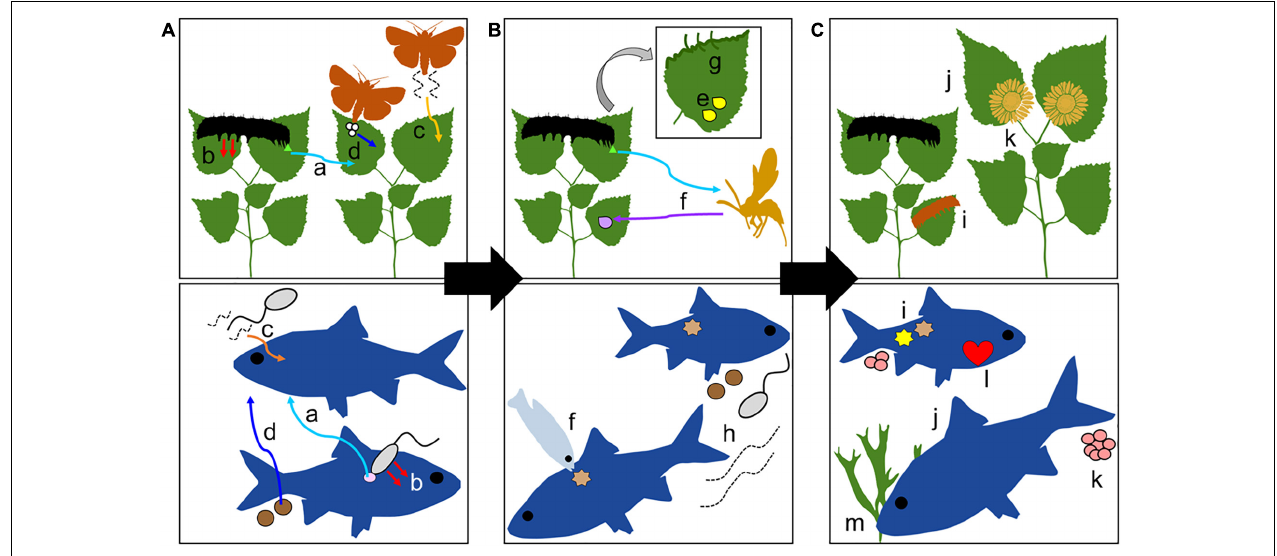
FIGURE 1 | Select broad similarities between plant-herbivore and host-parasite systems for the temporal sequence of events that can cause these natural enemies to have non-consumptive effects (NCEs): (A) perception of respective natural enemies; (B) enemy risk-induced trait responses (RITRs) related to victim resistance; and, (C) potential NCEs of enemy on victim. Specific pathways that are shared or unique between plant and animal victims for (A–C) : (a) chemical(s) generated by conspecific under attack, (b) tactile enemy perception, (c) enemy-generated chemical(s), i.e., kairomones, (d) risk proxies (conspecific feces, herbivore eggs), (e) production of secondary metabolites, (f) solicitation of enemy removal (chemical signals, energetic rewards), (g) morphology (trichomes, toughness), (h) spatial avoidance (conspecifics, enemies, proxies), (i) susceptibility to multiple enemies, (j) reduced growth or condition, (k) reduced reproduction, (l) metabolic costs, (m) altered foraging. Original silhouettes obtained from PhyloPic